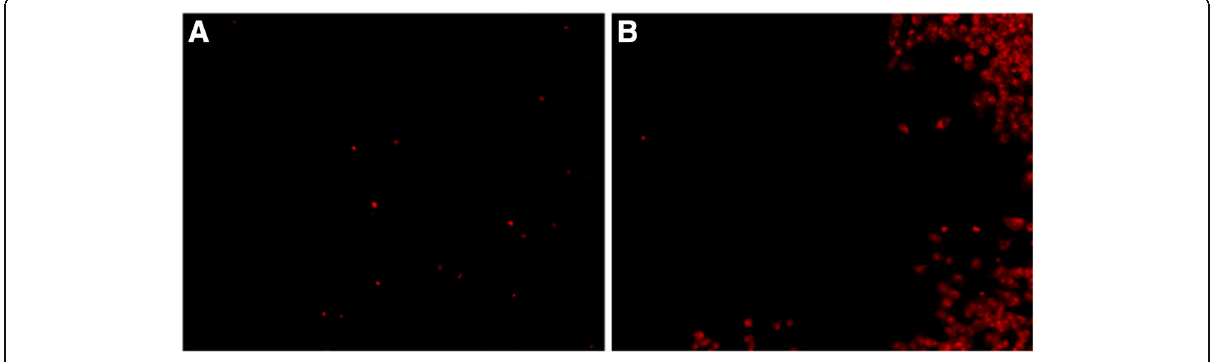
Fig. 12 PI staining of tumor cells with different treatments. a Control. b